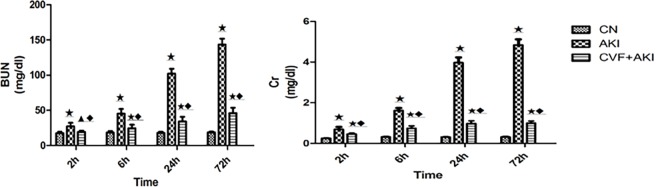
Levels of serum BUN and Cr.★ P<0.01▲ P>0.05 vs. control; ◆ P<0.01 vs. AKI.